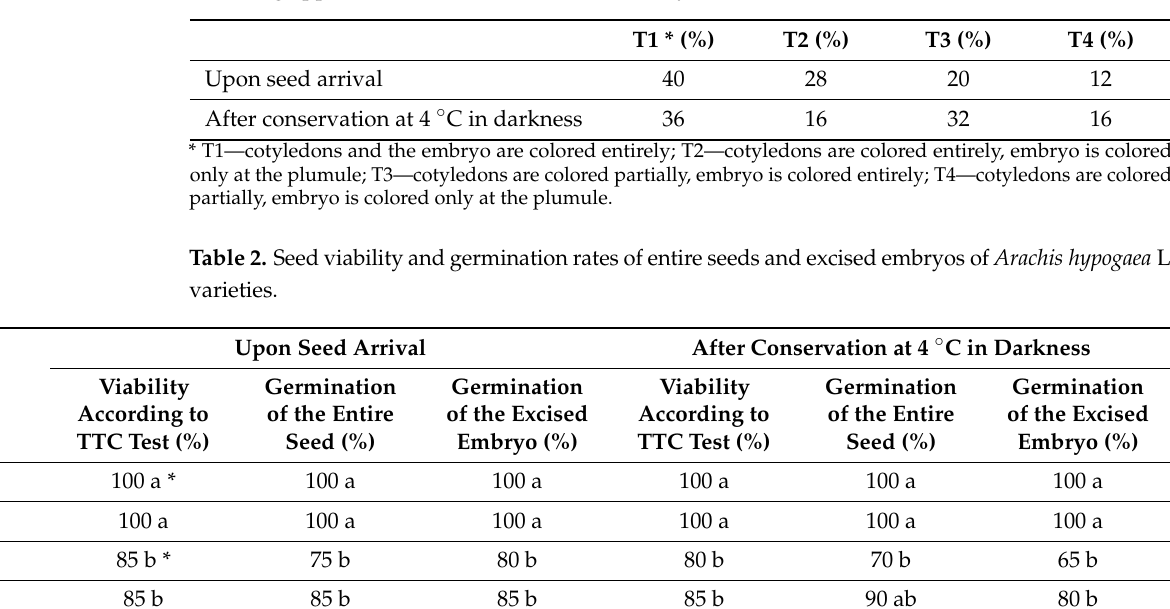
Table 1. Different typologies of red coloring observed with the Arachis hypogaea L. cv. Virginia seeds following application of TTC test for seed viability.